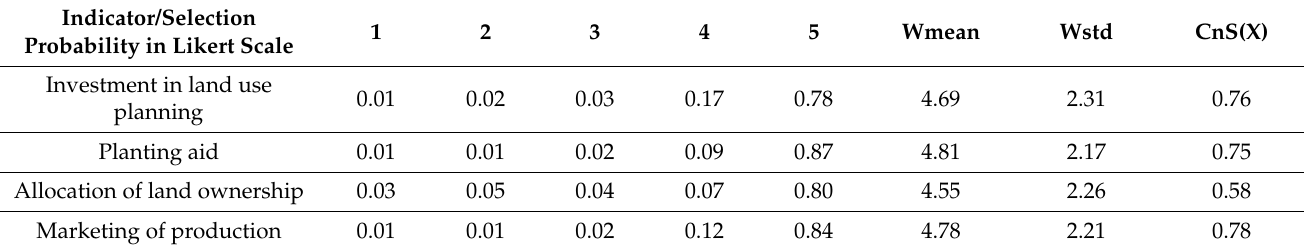
Table 10. Responses by households due to land use/land cover changes.